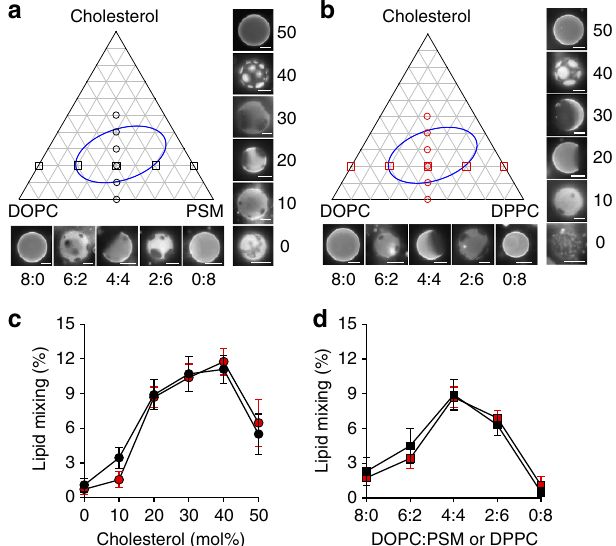
Figure 3 | Lipid phase-dependent membrane fusion mediated by HIV-FP. Ternary lipid mixtures composed of ( a ) PSM/DOPC/Ch or ( b ) DPPC/ DOPC/Ch with variable ratios were prepared as indicated in the triangular phase diagrams. Fluorescence micrographs of GUVs at constant 1:1 saturated:unsaturated lipid ratio with increasing cholesterol concentrations (0, 10, 20, 30, 40 and 50mol% on perpendicular axes of the phase diagrams) and GUVs at constant 20mol% cholesterol with variable DOPC/PSM (or DPPC) ratios (on horizontal axes of the phase diagrams). Scale bars, 10 m m. ( c ) Cholesterol- or ( d ) DOPC/PSM (or DPPC) ratio- dependent lipid mixing of 100 m M LUVs induced by 5 m M HIV-FP. LUVs are composed of the same lipid mixtures as used in a , b . PSM/DOPC/Ch and DPPC/DOPC/Ch data are shown with black and red symbols, respectively. Data are mean ± s.d. from three